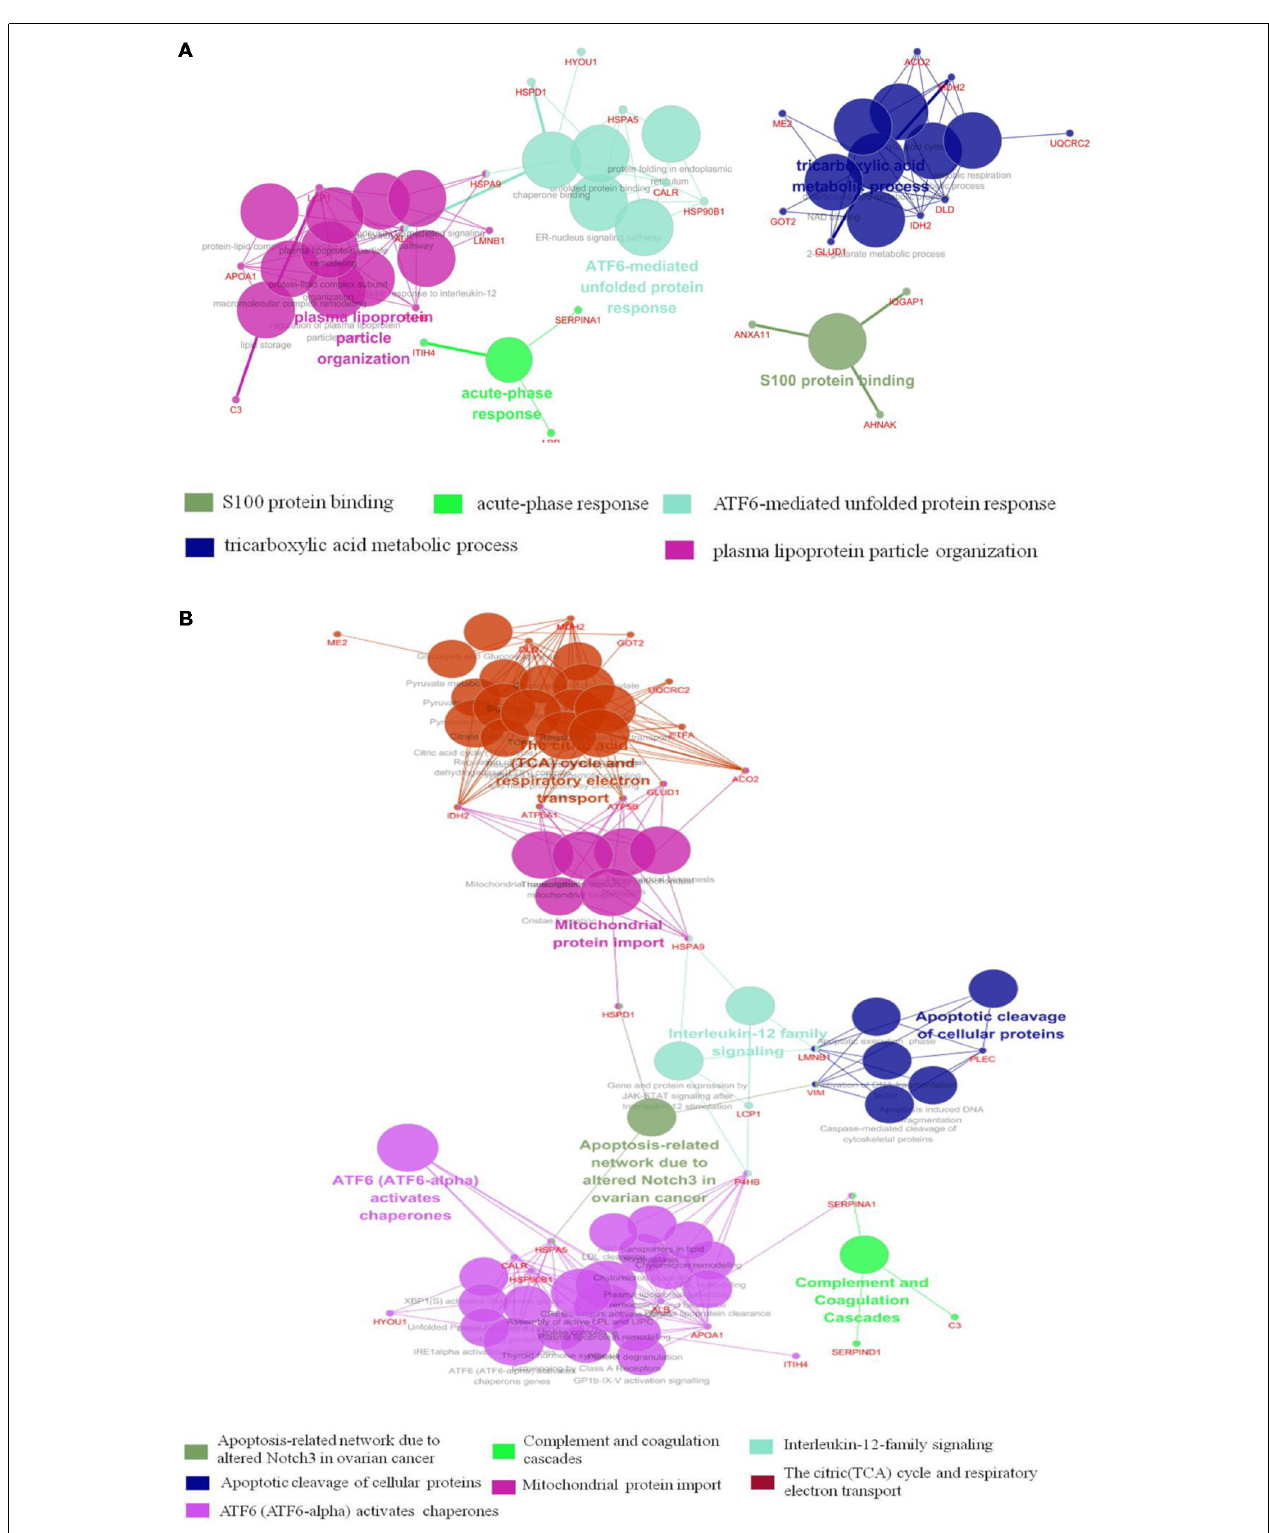
FIGURE 4 | Functional interaction network analysis was performed using ClueGO cytoscape plugin. (A) The differentially expressed 41 proteins were mapped to the GO categories (BPs and molecular function, MF). (B) The differentially expressed proteins were mapped to KEGG pathway, REACTOME pathway and Wiki pathway. Panels (A,B) are separately uploaded in the Supplementary Figure S1 .